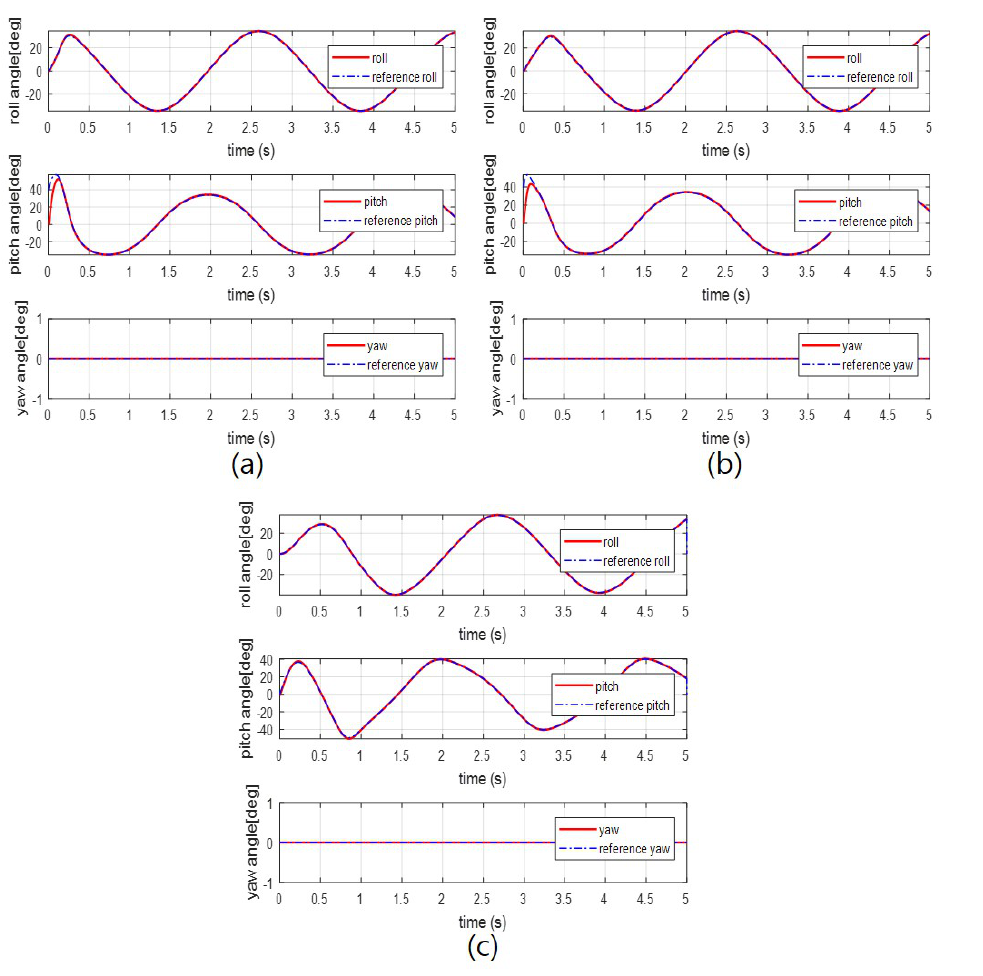
Figure 13. The attitude response for the trajectory tracking control: ( a ) Inverse optimal control; ( b ) LQR control; ( c ) PD